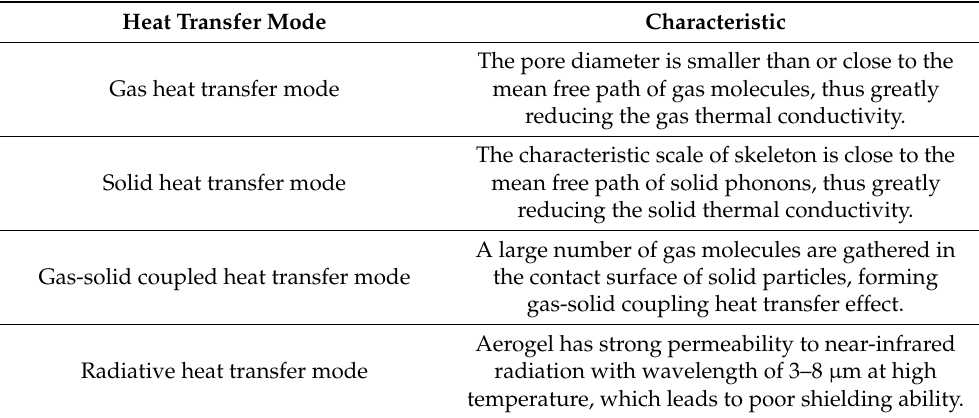
Figure 7. Gap between gas-solid coupling heat transfer and adjacent porous secondary nanoparticles ( a , D , Ai and d represent equivalent solid cubic element length, pore diameter, ring area of the i th hollow cylinder and particle size, respectively.): ( a ) Cylindrical element in gas-solid coupling effect zone; ( b ) Equivalent solid cubic element. Table 1. Characteristics of various heat-transfer models of aerogel.